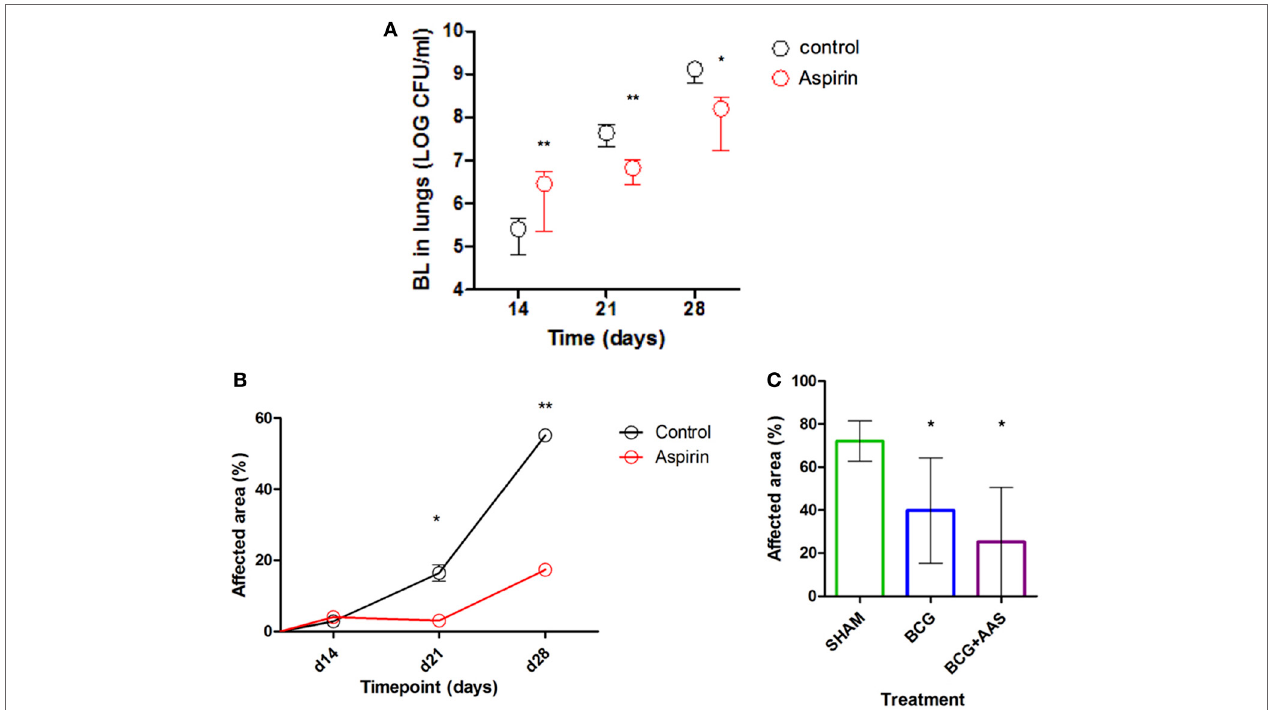
FigUre 2 | Impact of AAS on the BL and histometry. AAS, aspirin; BCG, bacille Calmette–Guerin vaccine; BL, bacillary load. Panel (a) shows the impact of AAS on the BL with time post-challenge. Panels (B,c) show the impact of AAS on the histometry in terms of affected lung area, both alone [ (B) : experiment 2] and in combination with BCG vaccine [ (c) : experiment